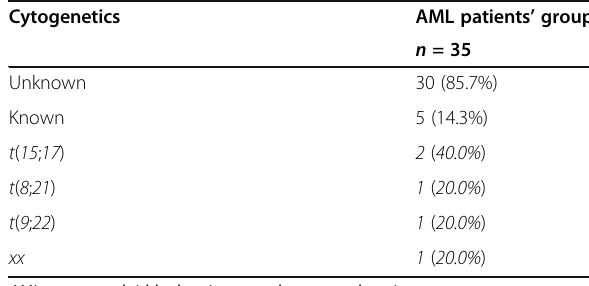
Table 2 Cytogenetic data of AML